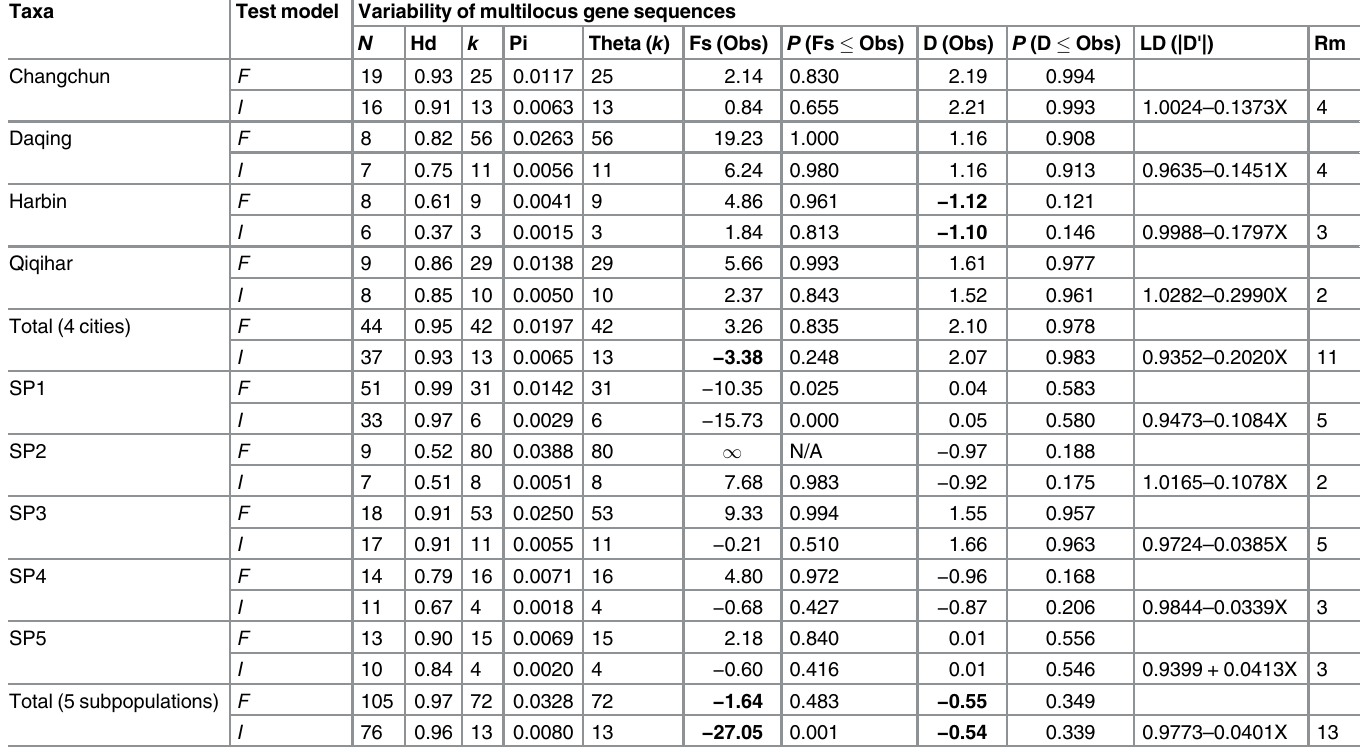
F : fi nite population genetic variance estimates; I : in fi nite population genetic variance estimates; N : number of multilocus genotypes; Hd: gene diversity; k : mean number of pairwise differences; Pi: nucleotide diversity (average over loci); Theta ( k ): gene variance based on mean number of pairwise differences; Fs/D (Obs): observed value of Fu ’ s/Tajima ’ s statistic testing selective neutrality based on allele frequency; P (Fs/D (cid:1) Obs): probability of obtaining Fs/D value equal or lower than the observed; LD (|D'|): linkage disequilibrium between sites and X is the nucleotide distance (measured in kilobases; kb); Rm: minimum number of recombination